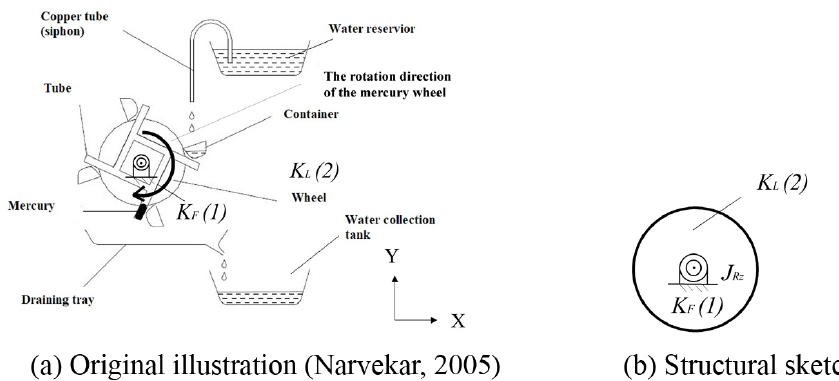
Figure 11. Mercury-driven water clock built by Indian mathematician